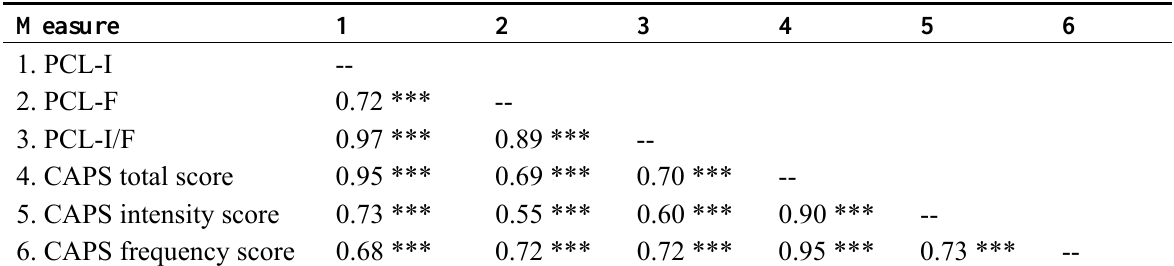
Table 1. Correlation matrix of PCL-I/F and CAPS.